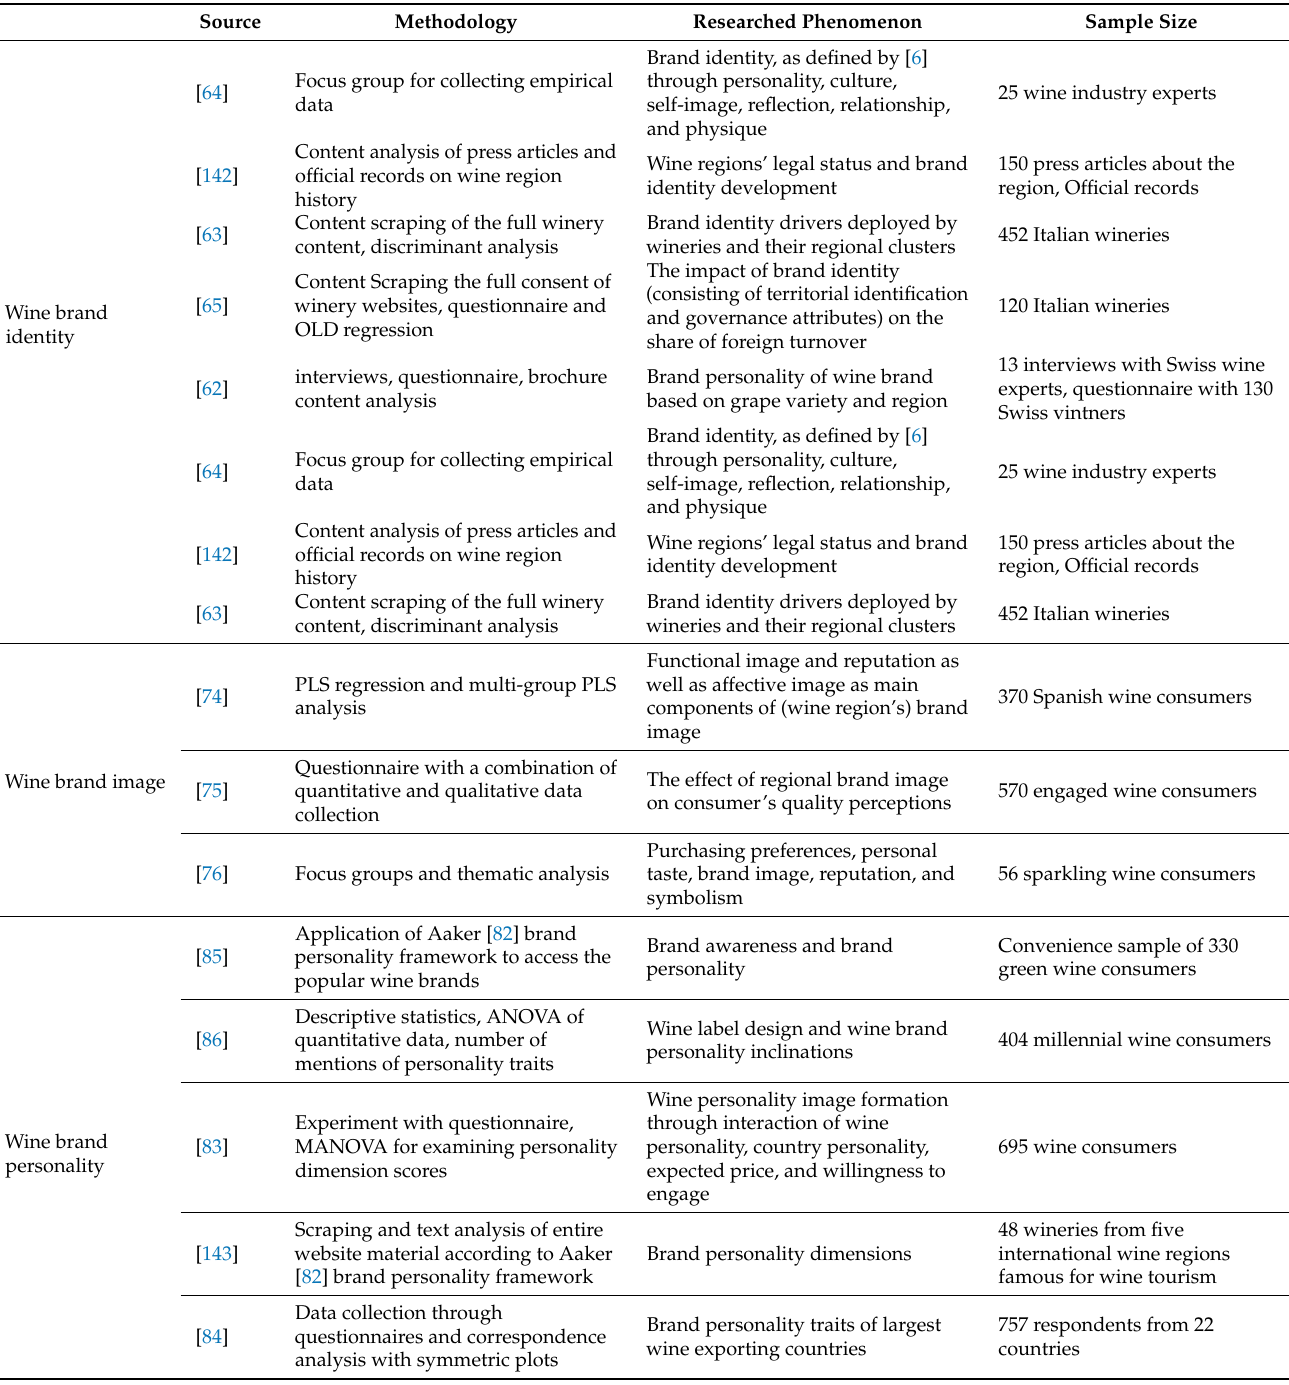
Table A2. Research field on wine branding: brand positioning, brand identity, brand image, and brand